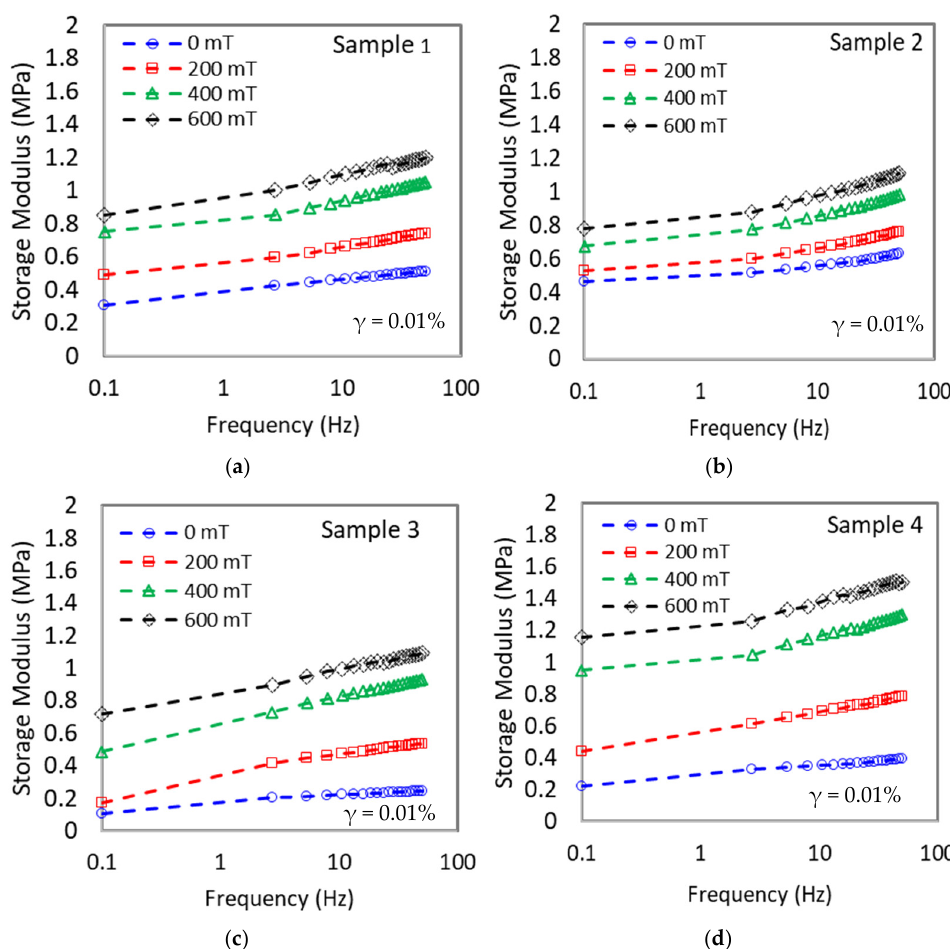
Figure 4. Variations of shear storage modulus with frequency at different magnetic flux densities for ( a ) Sample 1, ( b ) Sample 2, ( c ) Sample 3, and ( d ) Sample 4. Table 5. The rheological properties of MRE samples under frequency sweep.